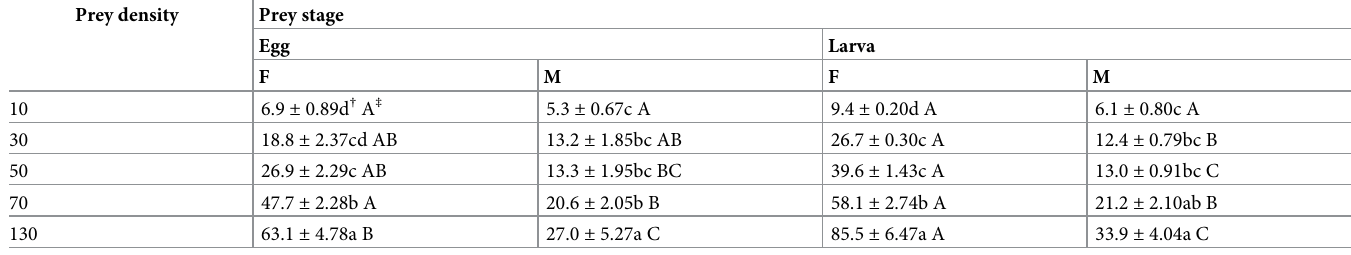
Table 3. Comparison of predation rate (as number of prey consumed, mean ± SE) of Amblyseius eharai adults (F: Female or M: Male) on eggs and larvae of Tetrany- chus urticae